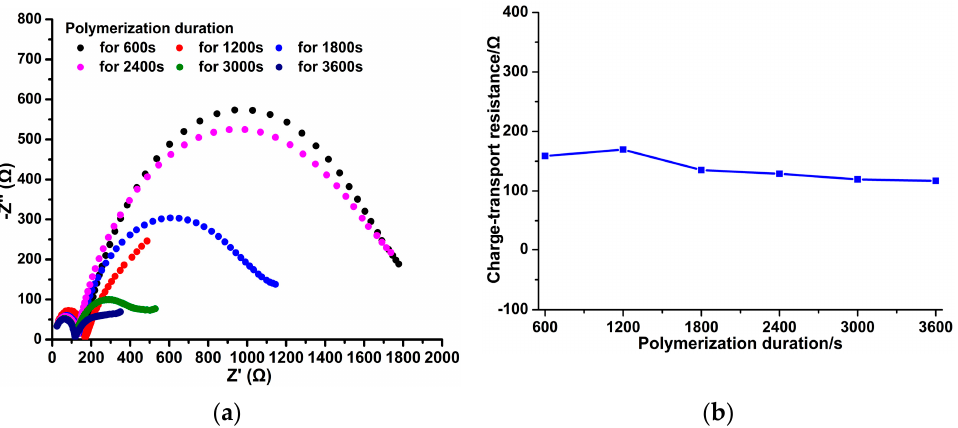
Figure 9. EIS with the equivalent circuit ( a ), and charge transfer resistance Rct ( b ) of PPy-NS ISEs in 0.1 M NaNO 3 solution.